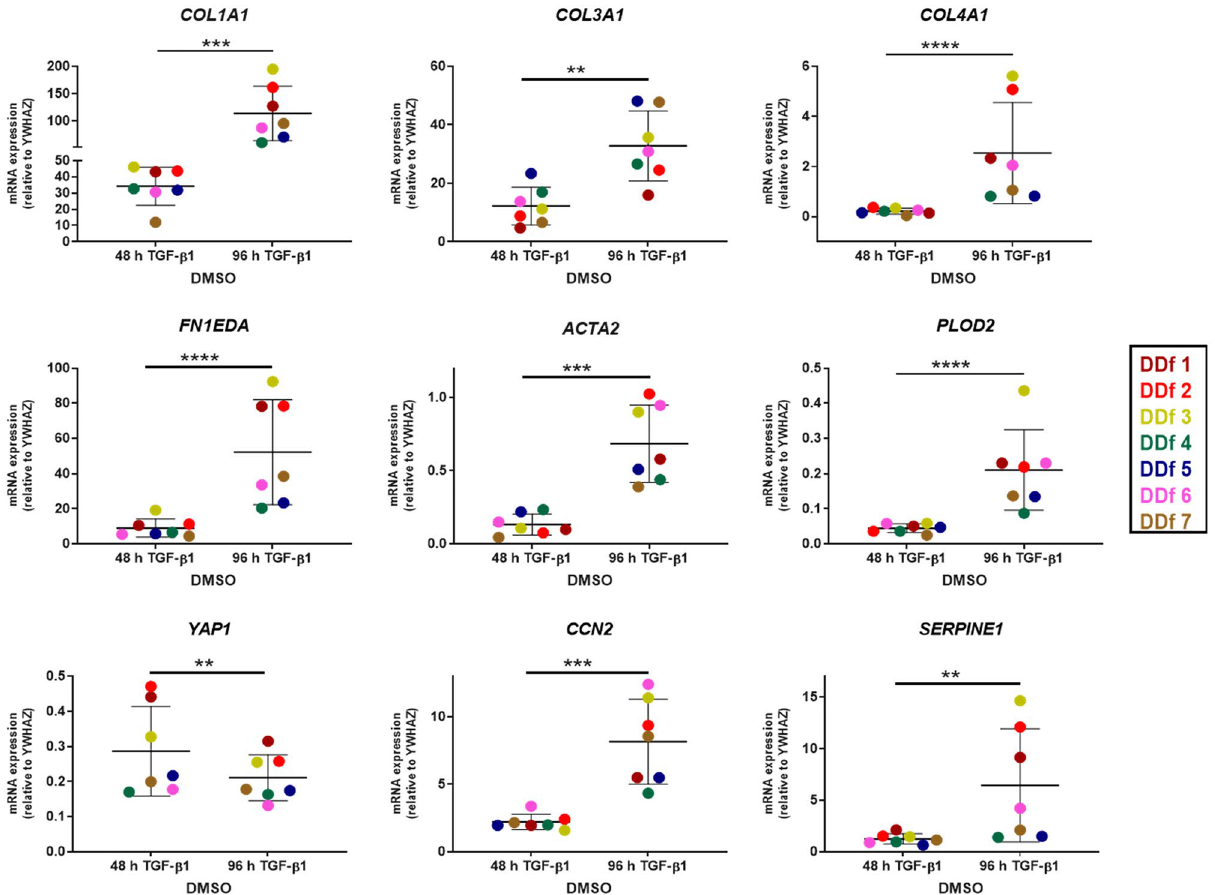
Figure 2. Effect of 48 h and 96 h TGF-β1 stimulation (5 ng/ml) of DD nodule-derived fibroblasts (n = 7) in the absence of verteporfin. mRNA expression of COL1A1, COL3A1, COL4A1, FN1EDA, ACTA2, PLOD2, YAP1, CCN2 and SERPINE1 relative to